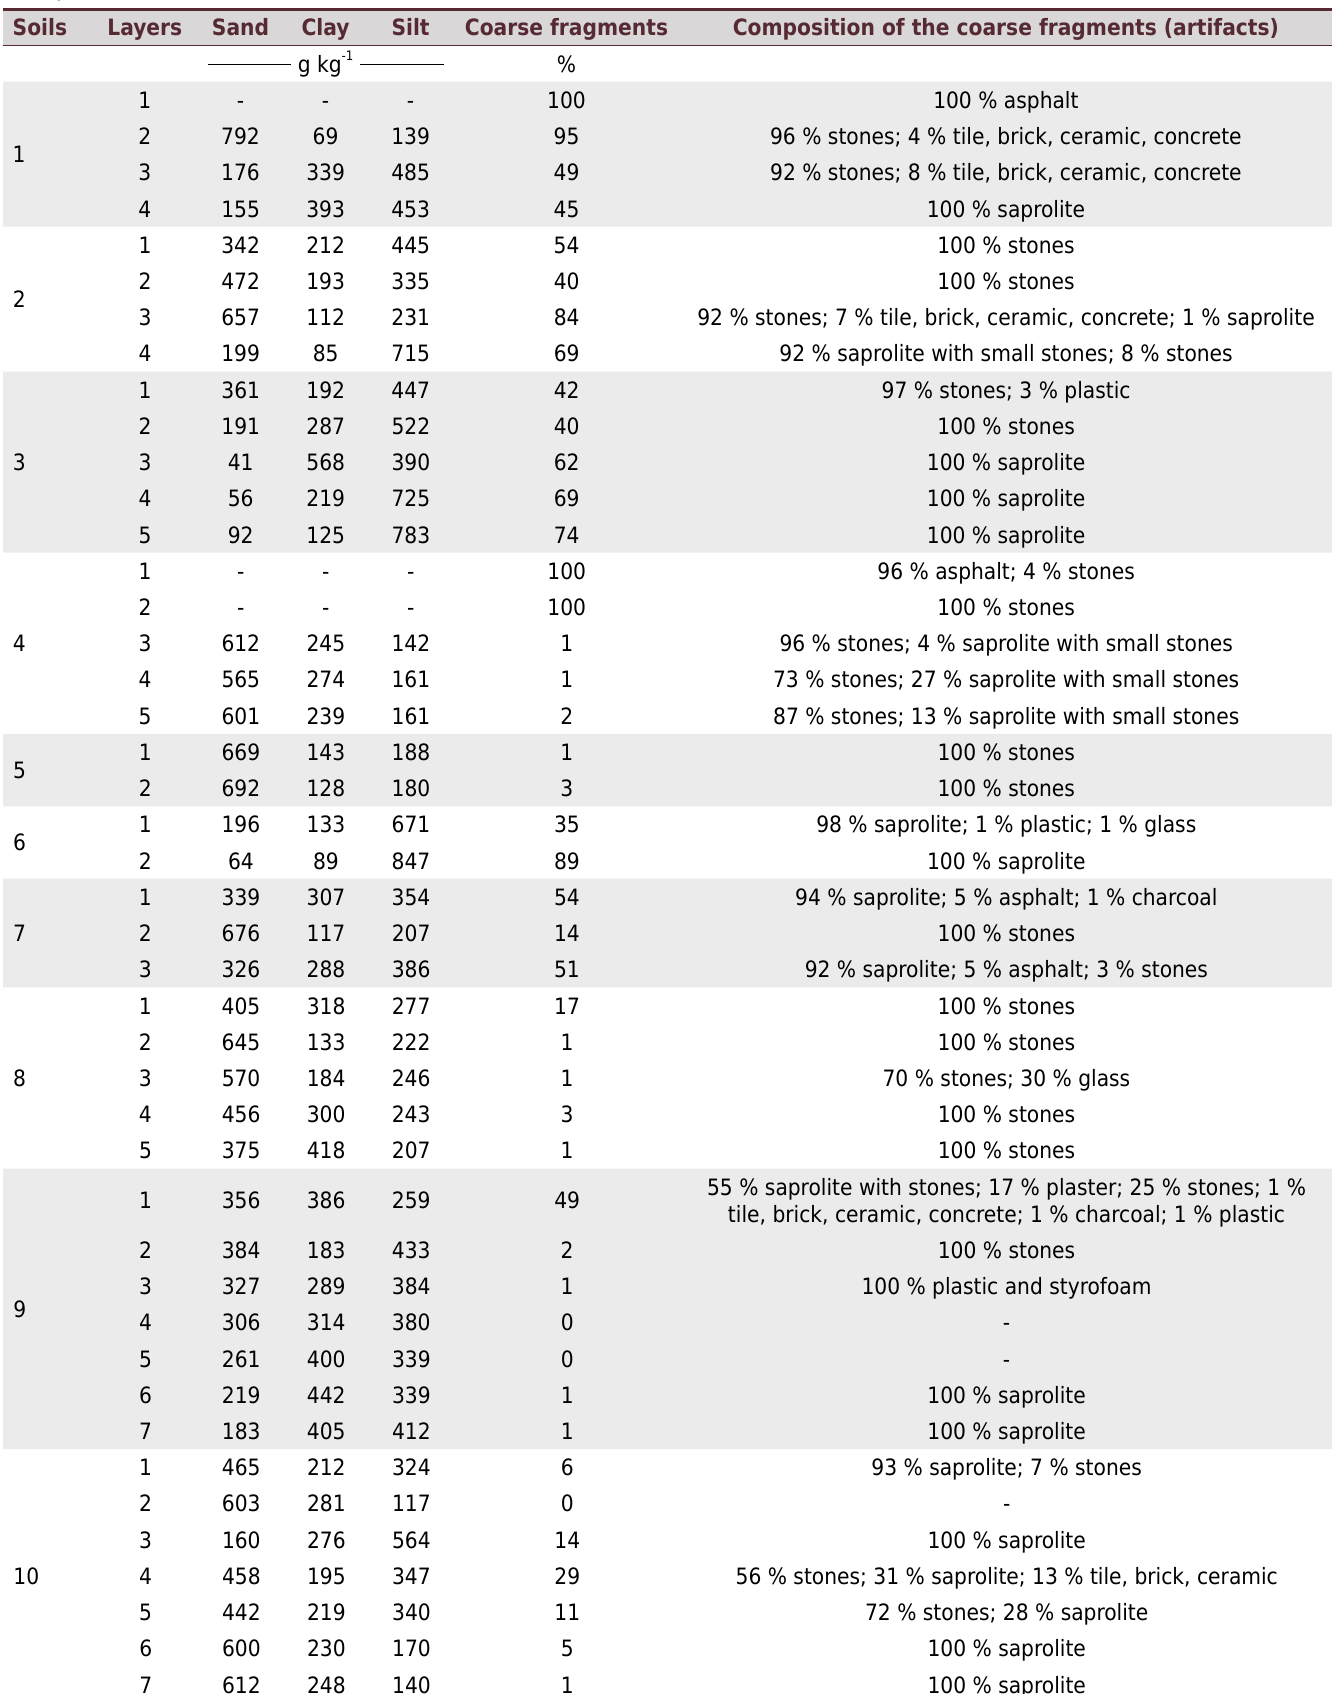
Table 4. Particle size distribution and composition of the coarse fragments in the urban soils of Santa Maria, Rio Grande do Sul State, Brazil Soils Layers Sand Clay Silt Coarse